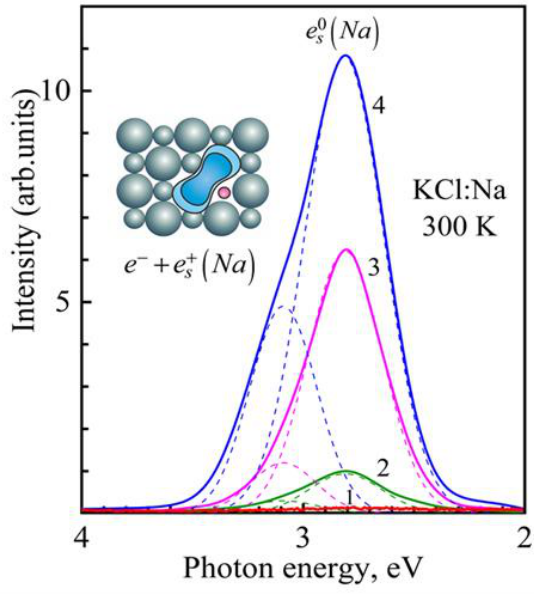
Figure 4. XRL spectra measured for KCl:Na (100 ppm) crystals after long-term storage at RT (curve 1) or after additional quenching of a “decayed” crystal at 400 °C (curve 2), 520 °C (curve 3), and 700 °C (curve 4). All spectra were measured at RT. The results of the XRL decomposition into elementary Gaussians are indicated by dotted lines. The insert shows a model of an exciton-like formation (a bound exciton) in the field of a sodium ion, Na + c .